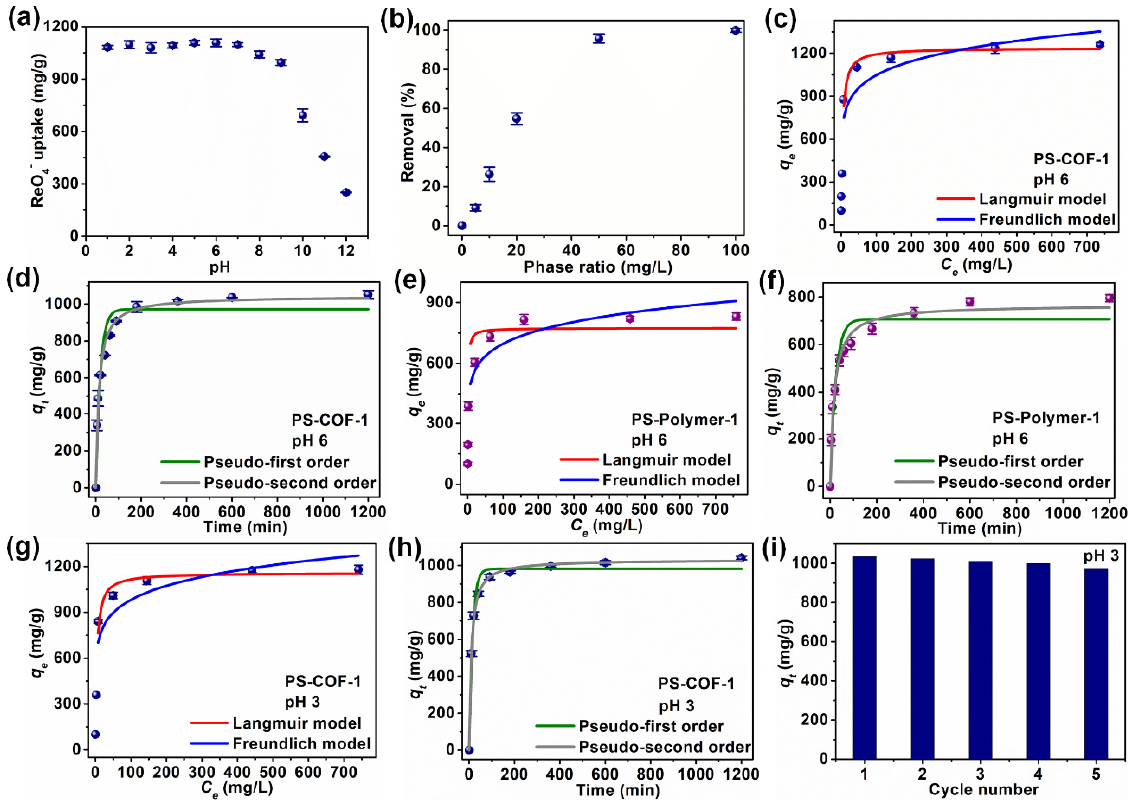
Figure 8. ReO 4 − adsorption results. ( a ) Effect of pH on the removal of ReO 4 − , ( b ) ReO 4 − removal by PS-COF-1 at various adsorbent − liquid ratios, ( c , e ) Equilibrium adsorption isotherms for ReO 4 − on PS-COF-1 and PS-Polymer-1 at pH 6, respectively, ( d , f ) ReO 4 − adsorption kinetics on PS-COF-1 and PS-Polymer-1 at an initial ReO 4 − concentration of ~56 ppm (pH 6), respectively, ( g , h ) Equilibrium isotherms and adsorption kinetics of ReO 4 − on PS-COF-1 at pH 3, respectively, ( i ) Recycle test data for ReO 4 − removal in HNO 3 (at pH 3) solutions by PS-COF-1 [57], Copyright 2022